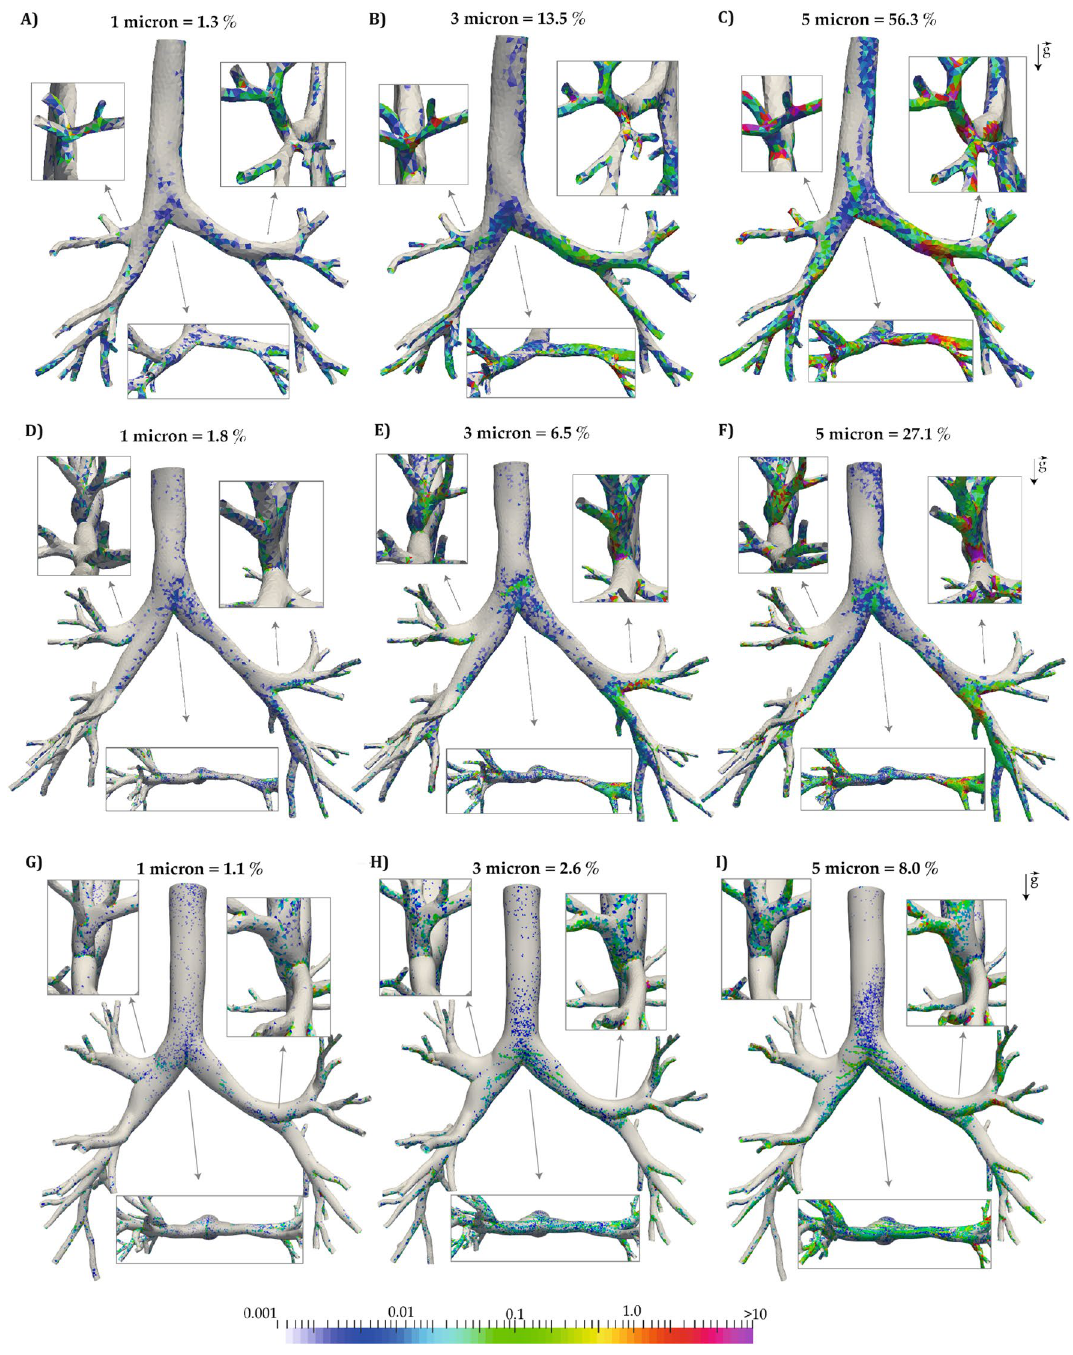
N e (cid:31) T ) for the infant model (panel A – C ), for the N T (cid:31) e